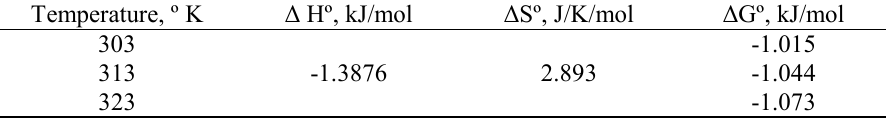
Table 4. Thermo dynamical parameters for the adsorption of AG 25 onto